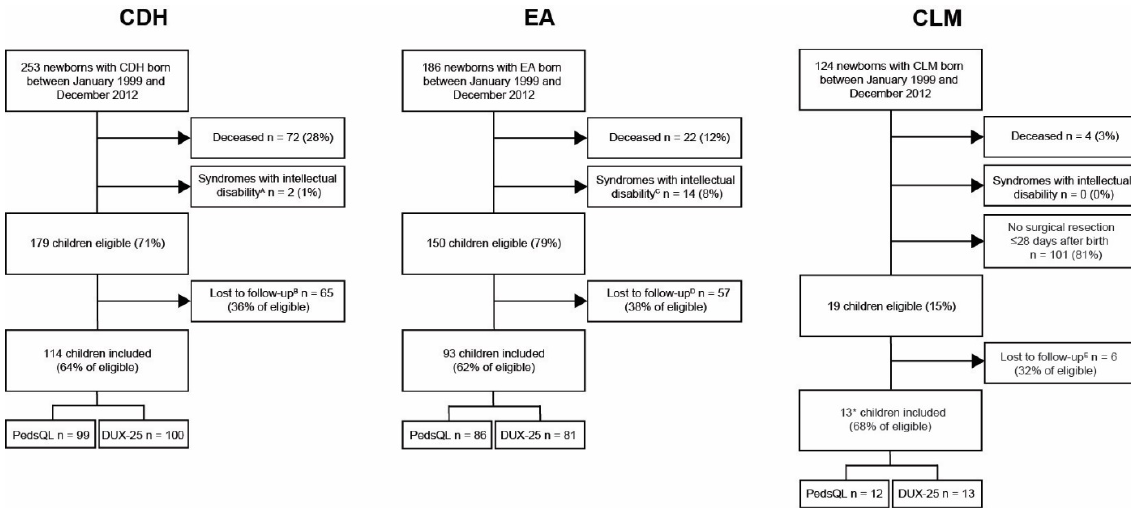
Figure 1 . Flowcharts of included patients. CDH = congenital diaphragmatic hernia, EA = esophageal atresia, CLM = congenital lung malformation. A Wolf-Hirschhorn syndrome n = 1, Simpson–Golabi–Behmel syndrome n = 1. B emigration n = 5, organizational reasons n = 27, no neuropsychological assessment n = 7, no follow-up scheduled at 8 years n = 2, no self-reports due to lack of time n = 2, age ≥ 9 years due to postponement of follow-up visit n = 1, refusal n = 18, follow-up elsewhere n = 1, untraceable n = 2. C Down syndrome n = 5, Opitz syndrome n = 1, Goldenbar syndrome n = 1, Wolf– Hirschhorn syndrome n = 1, Mandibulofacial dysostosis Guion Almeida type n = 1, 22q11 duplication syndrome n = 1, other n = 4. D emigration n = 6, organizational reasons n = 4, no neuropsychological assessment n = 6, no follow-up sched-